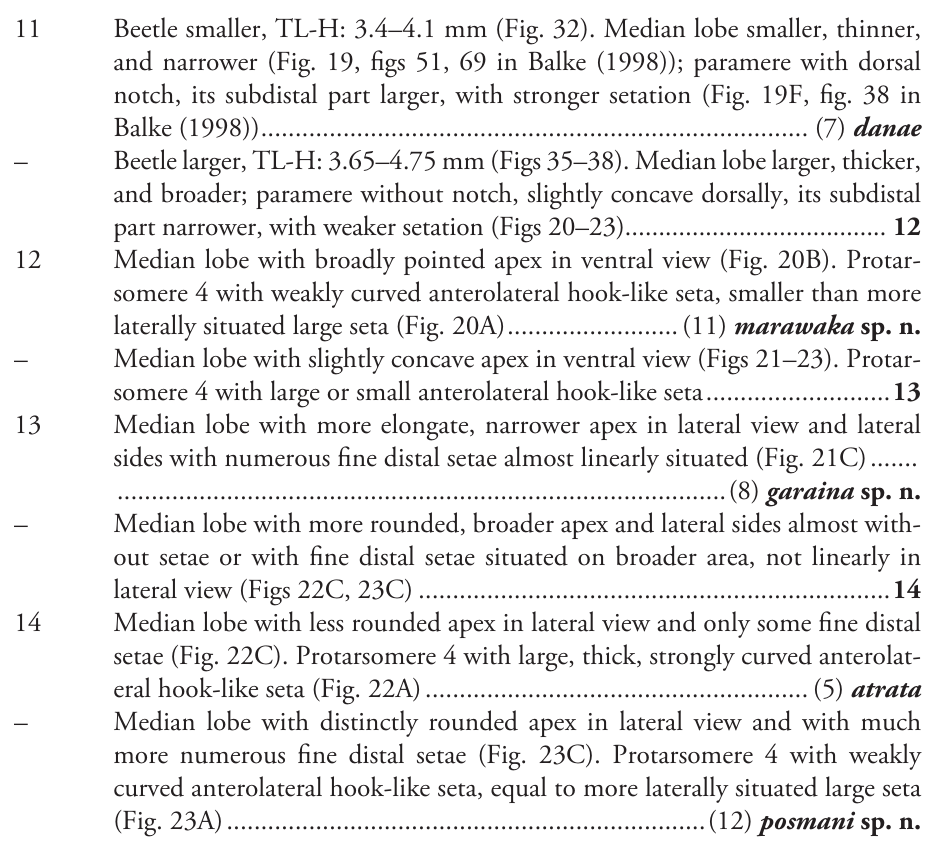
(Fig. 23A) ......................................................................(12) posmani sp. n.